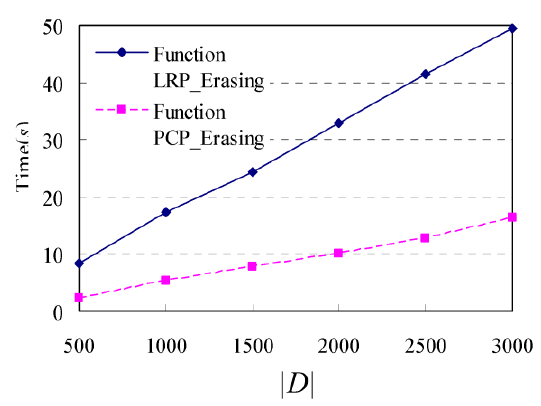
Figure 11. Execution time in response to changes in different |D| .